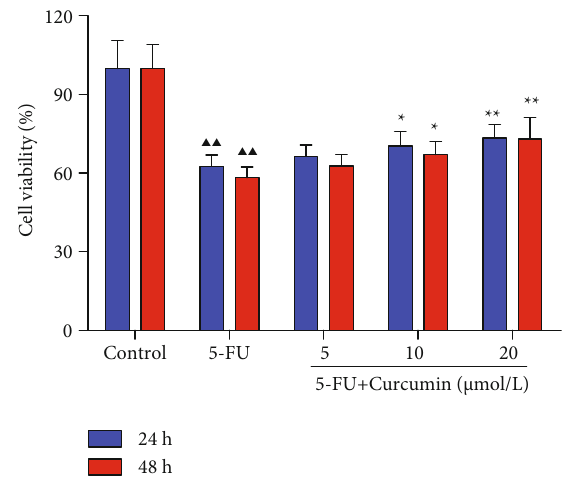
Figure 1: E ff ect of curcumin on the cell viability of the 5-FU- stimulated IEC-6 cells. IEC-6 cells were stimulated with 5-FU for 24 h and then further treated with curcumin at 5, 10, and 20 μ mol/L for 24 h or 48h. CCK-8 assays were performed to detect the cell viability of each group cells. Data were expressed as mean ± standard errormean (SEM), ▲▲ p value < 0.01 vs. control group; ∗ p value < 0.05 vs. 5-FU group; ∗∗ p value < 0.01 vs. 5-FU group. 5-FU: 5- fl